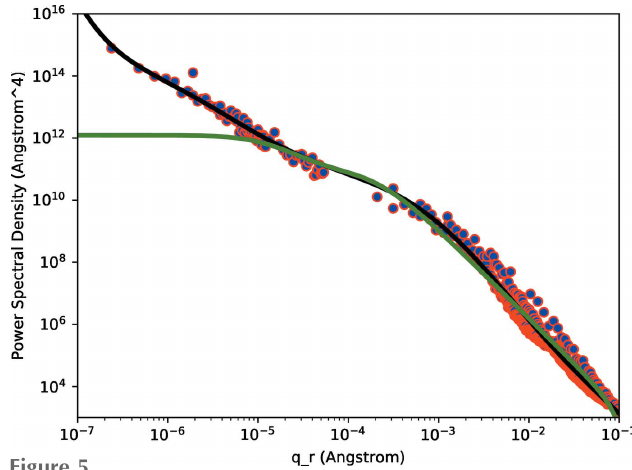
Figure 5 Power spectral density of the rough sample. The data points were obtained from optical interferometry and from atomic force microscopy. The solid black curve is a polynomial fit to the concatenated data set. The solid green curve results from equation (8) applied to the correlation function shown in Fig. 6.